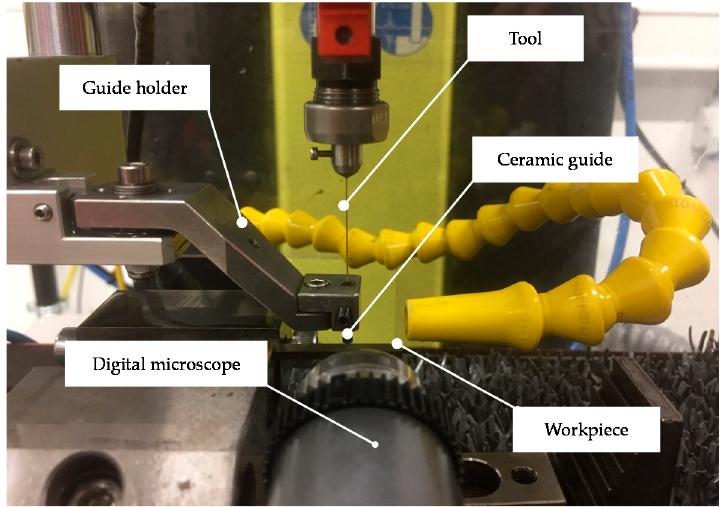
Figure 2. Experimental setup.